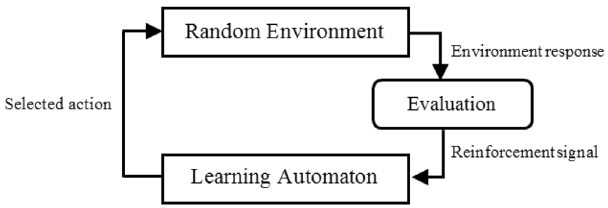
Figure 1. Relationship between LA and its random